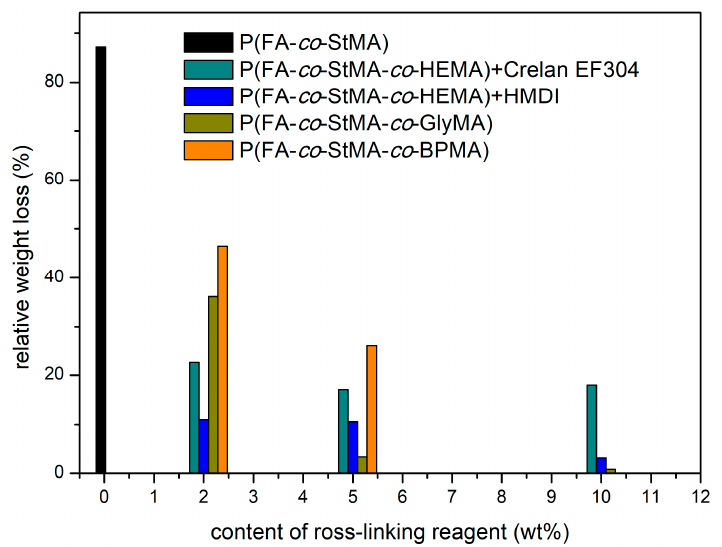
Figure 9. Weight loss of polymer-coated fibers by extraction in the Soxhlet apparatus, relative to the initial coated cellulose substrate weight.